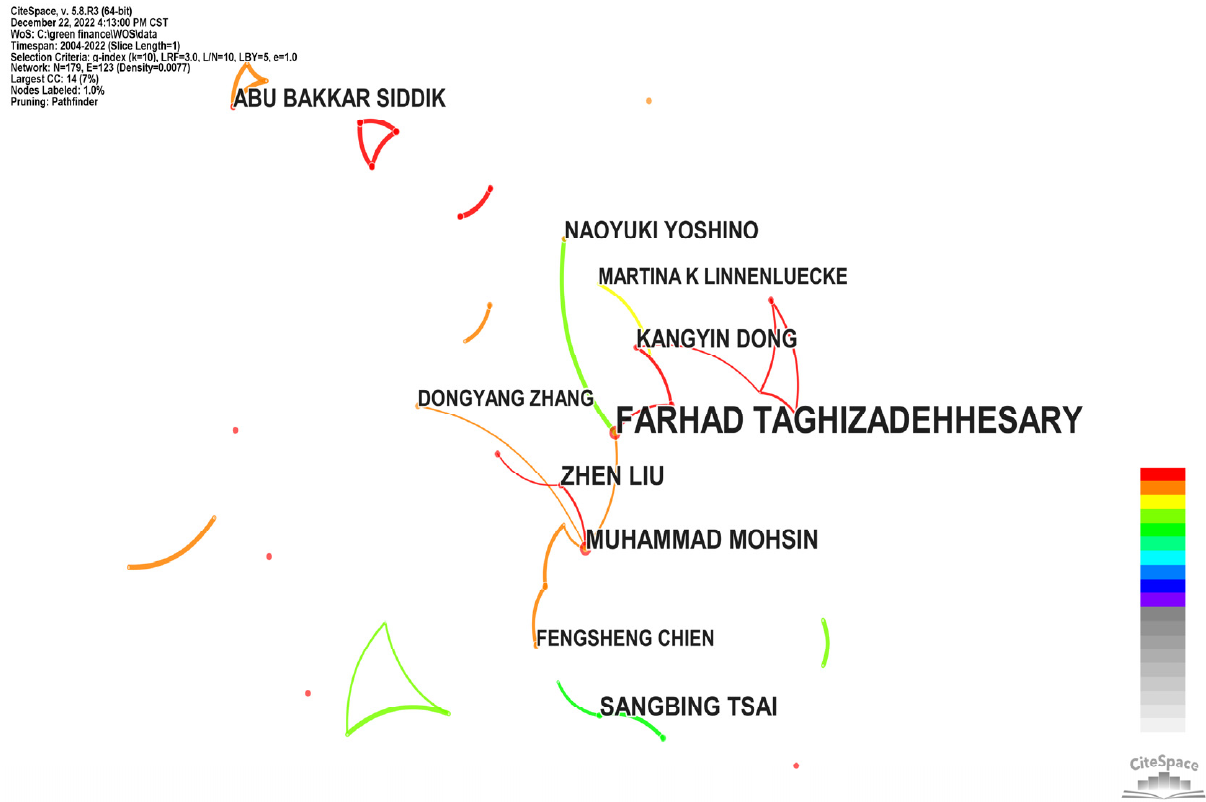
Figure 3. Domestic author cooperation chart.